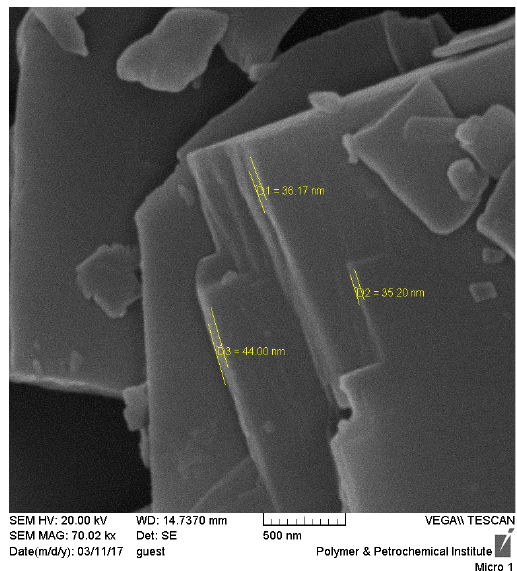
Fig. 2. SEM micrographs of the Cu